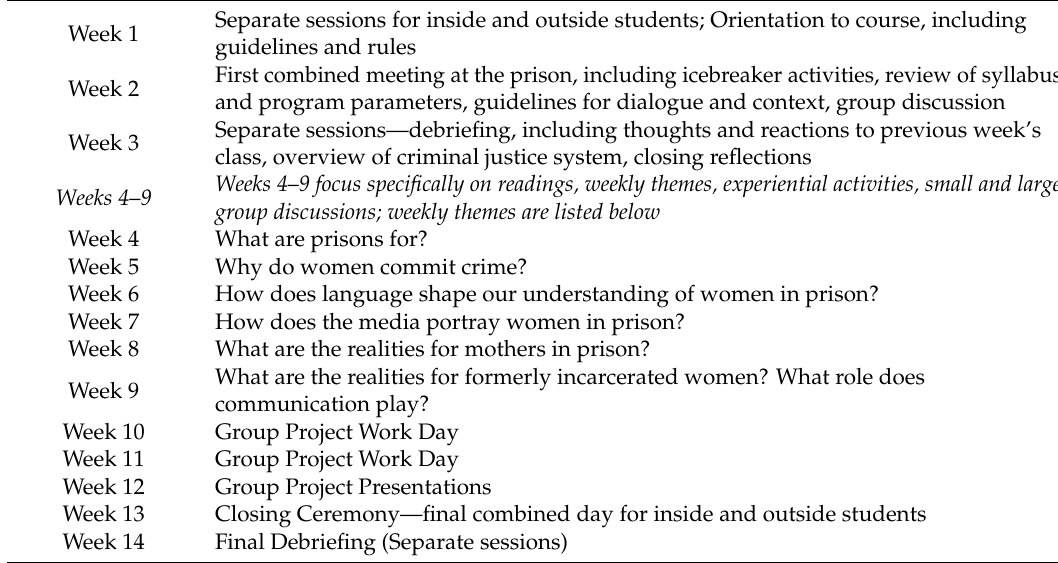
Table 1. Course Schedule and